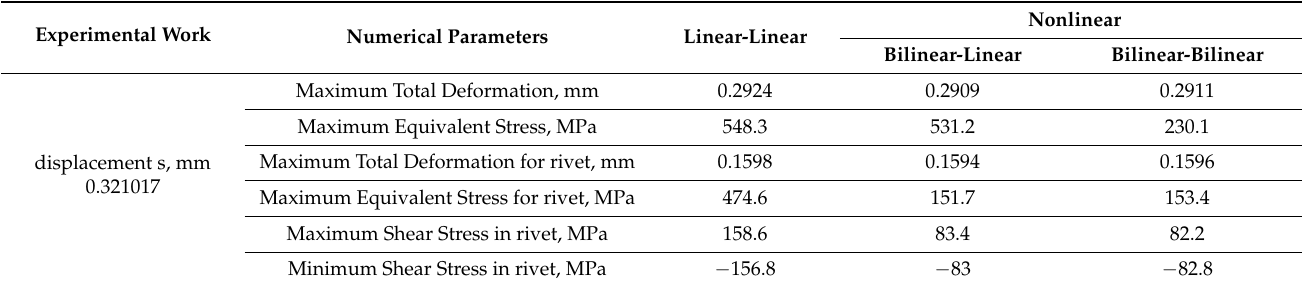
Table A4. Experimental and numerical results for the load force F = 800 N.